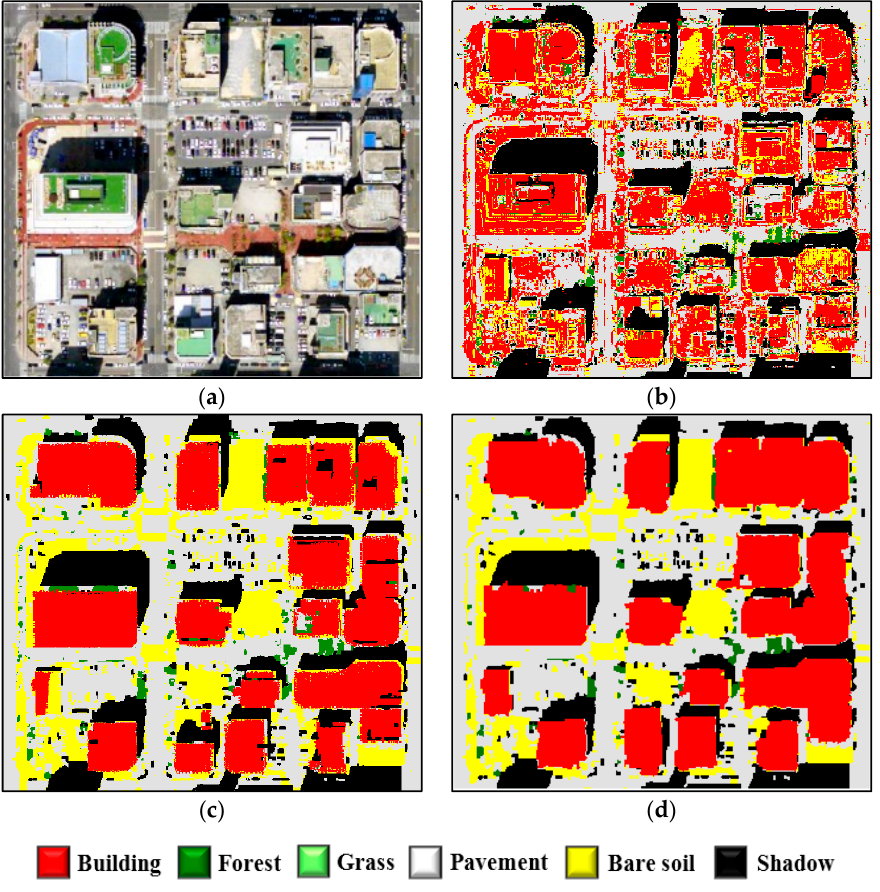
Figure 9. Results for site 4: ( a ) aerial image; ( b ) Max-Min method; ( c ) SSI, nDSM method; and ( d ) the new method.